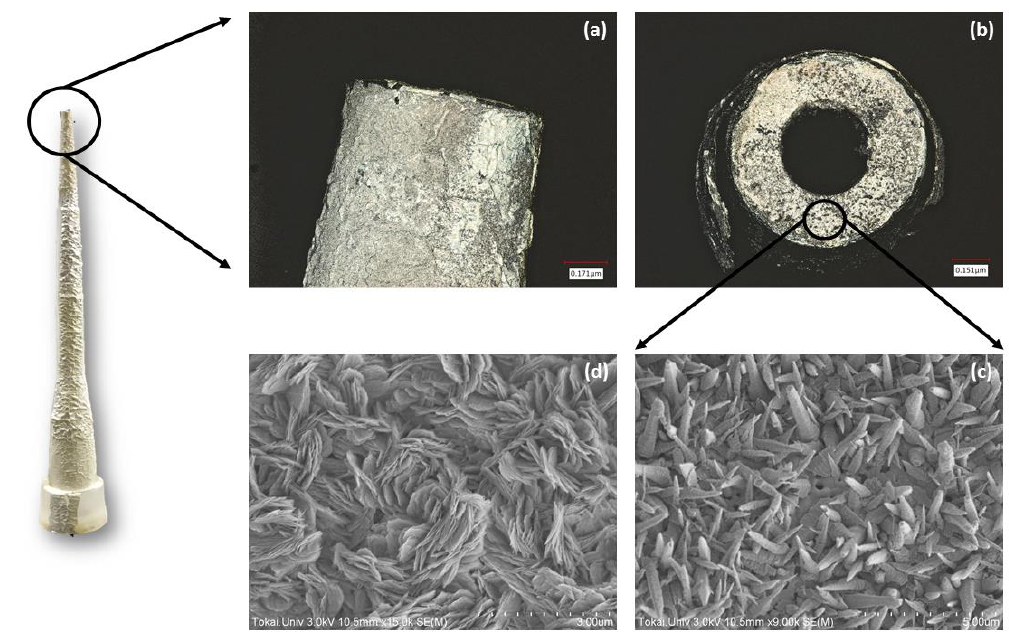
Figure 4. ( a , b ) Laser microscope images of the grown ZnO nanostructures over micropipette tip at 10x magnification in different orientations ( c , d ) SEM images of aggregated ZnO platelet-like nanostructures at 9 k and 15 k magnifications, respectively.